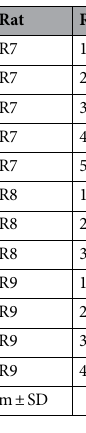
n , to the changes in acinar surface